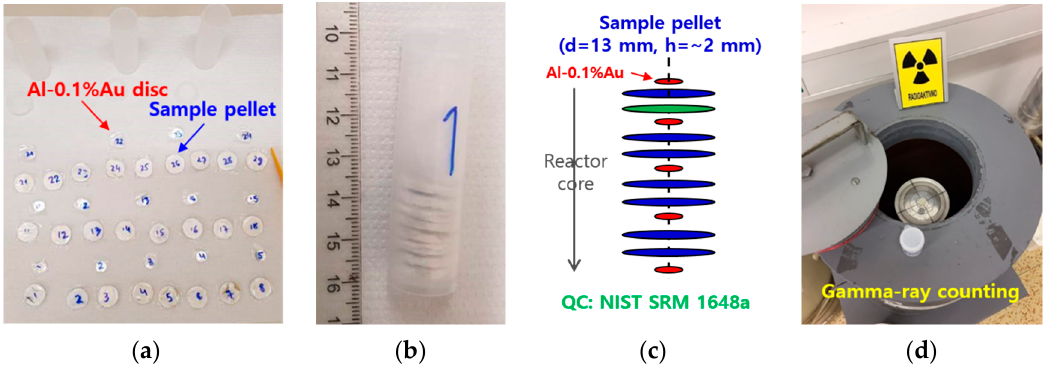
Figure 2. Image of ( a ) prepared sample pellets and Al ‐ 0.1%Au discs; ( b ) rabbit for irradiation; ( c ) arrangement of samples and Al ‐ 0.1%Au discs in rabbit; ( d ) gamma ‐ ray counting system at JSI.